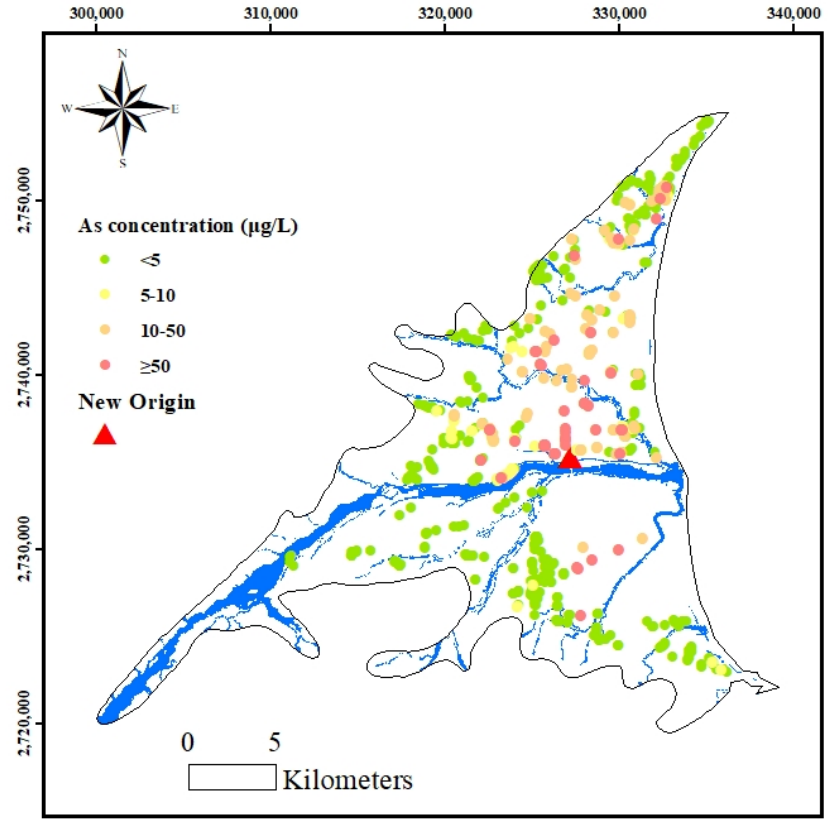
Figure 3. Geographical distribution of the measured As concentrations.